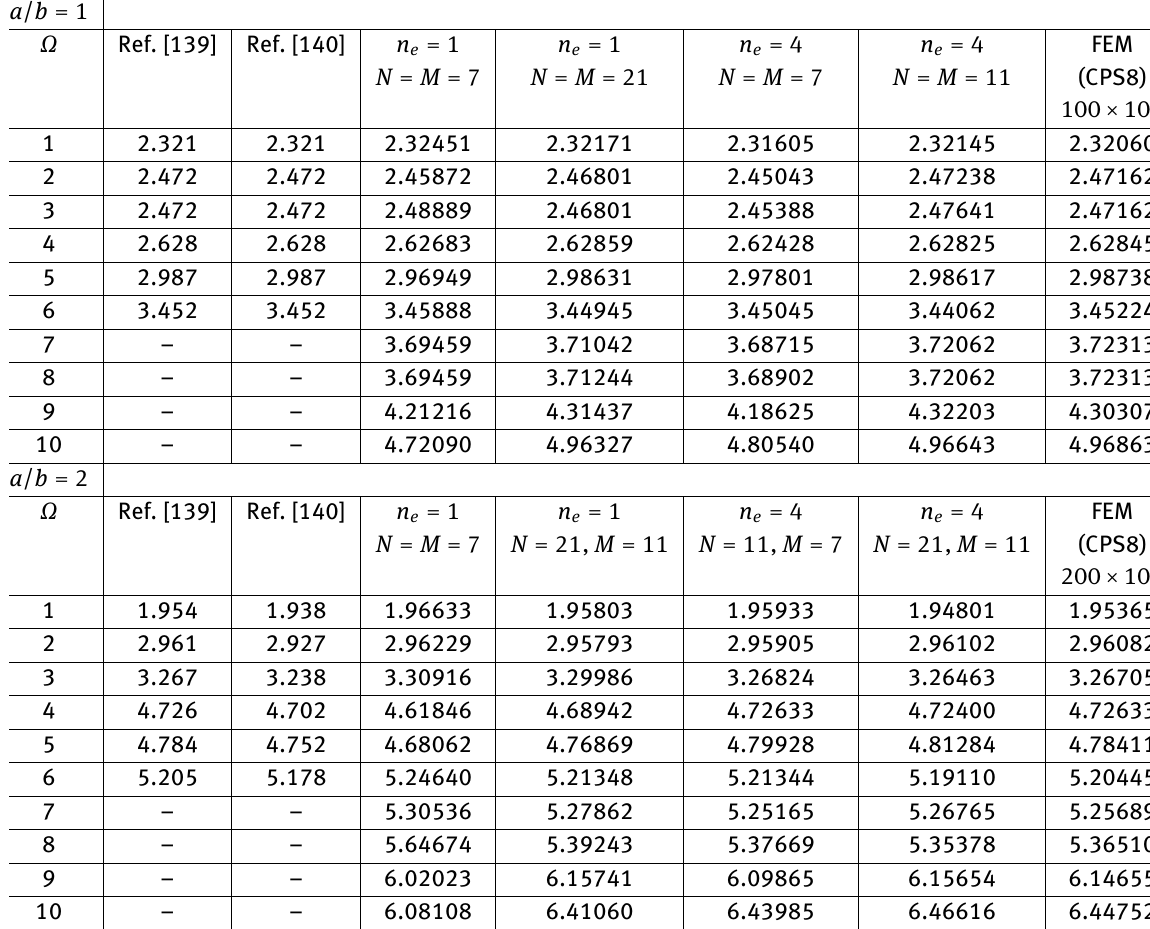
Table 2: First ten dimensionless frequencies for F-F-F-F isotropic in-plane square and rectangular plates using different techniques. a / b =